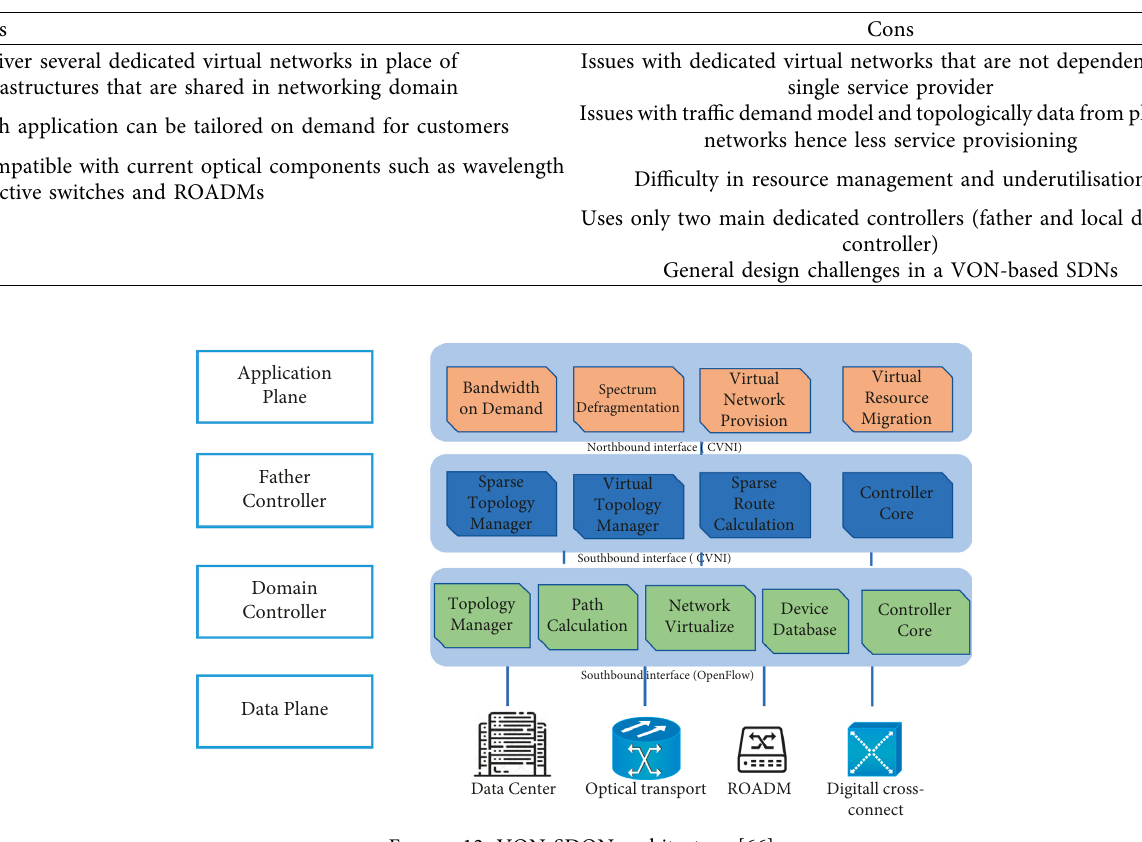
Figure 12: VON-SDON architecture [66].